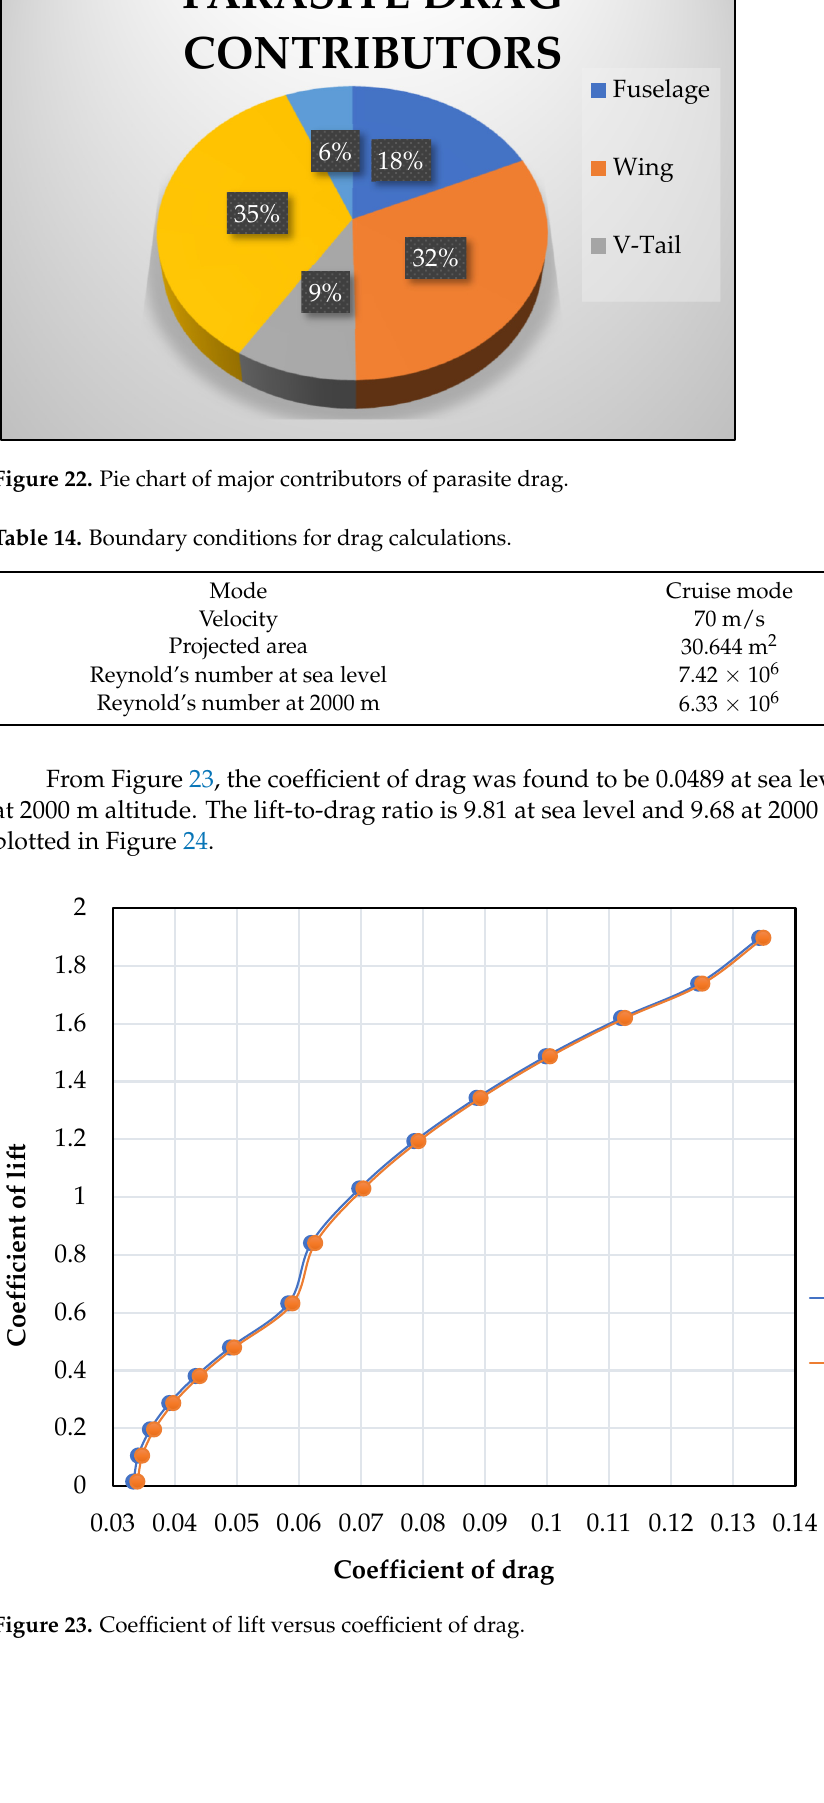
Figure 24. Lift-to-drag ratio versus angle of attack. 9.7. Thrust Calculation The thrust force is the force that propels the aircraft forward. In this case, it also pro- vides the power required for vertical take-off and landing. The thrust force is produced by open tilt-rotor-type propellers. There are six propellers in the present eVTOL model. A single propeller with a hub was designed in SolidWorks, as shown in Figure 25. The thrust produced by a single propeller was calculated in ANSYS Fluent under steady level flight conditions. The thrust was 222.86 N after applying the following boundary conditions in Table 15.